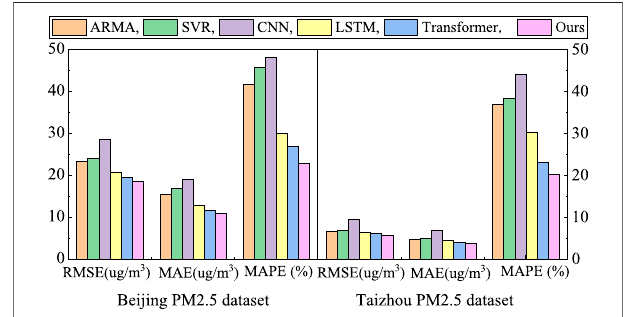
FIGURE 6 | Comparisons of different methods for single-step PM2.5 prediction tasks for the next 1